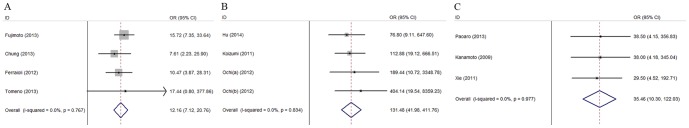
Forest plot from meta-analysis of DOR value using a random-effect or fixed-effect model for significant fibrosis.(A) Forest plot of LFI and (B) Forest plot of ER1 and (C) Forest plot of ER2. DOR: diagnostic odds ratio; LFI: liver fibrosis index; ER1: the elastic ratio of the liver for the intrahepatic vein; ER2: the elastic ratio of the liver for the intercostal muscle; Ochi (a): the training set of the subjects in the study by Ochi et al; Ochi (b): the validating set of the subjects in the study by Ochi et al.